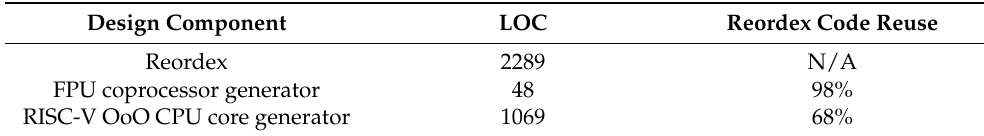
Table 4. Code reuse evaluation for Reordex and designs based on it. Design